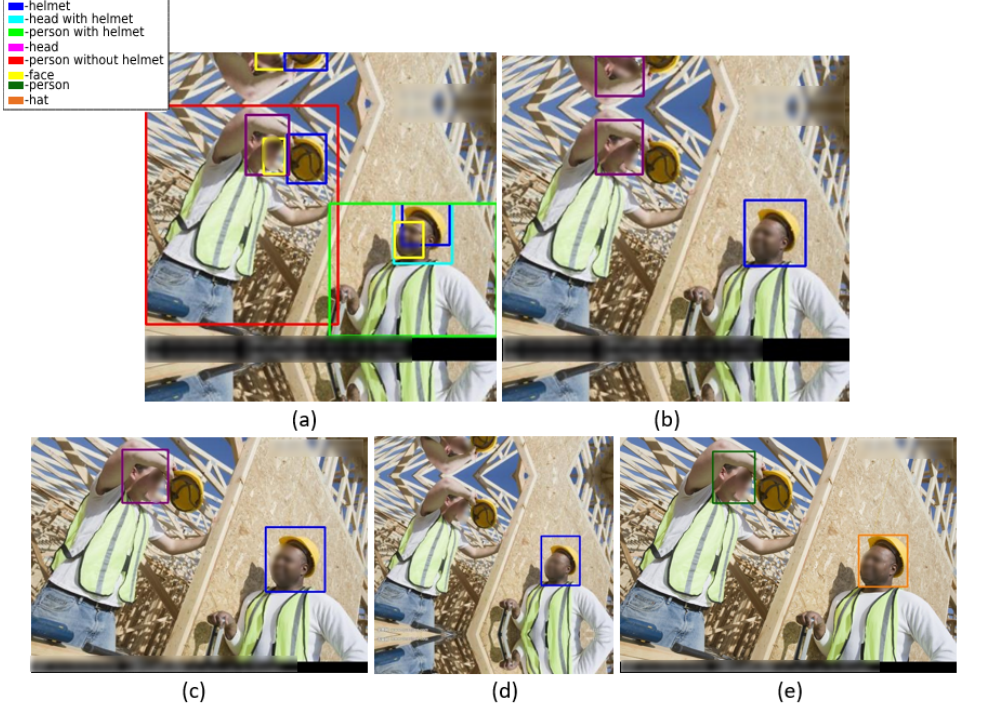
Figure 1. Comparison of public safety helmet datasets’ labels and SHEL5K dataset’s labels: ( a ) SHEL5K dataset, ( b ) SHD dataset [8], ( c ) hardhat dataset [20], ( d ) HHW dataset [27], and ( e ) SHW dataset